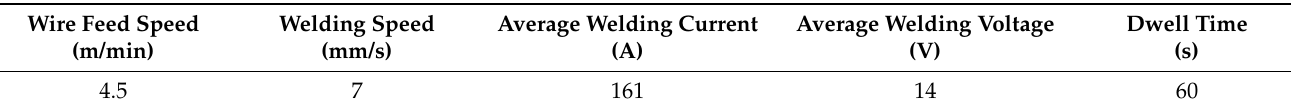
Table 3. Deposition parameters of wire arc additive manufacturing.